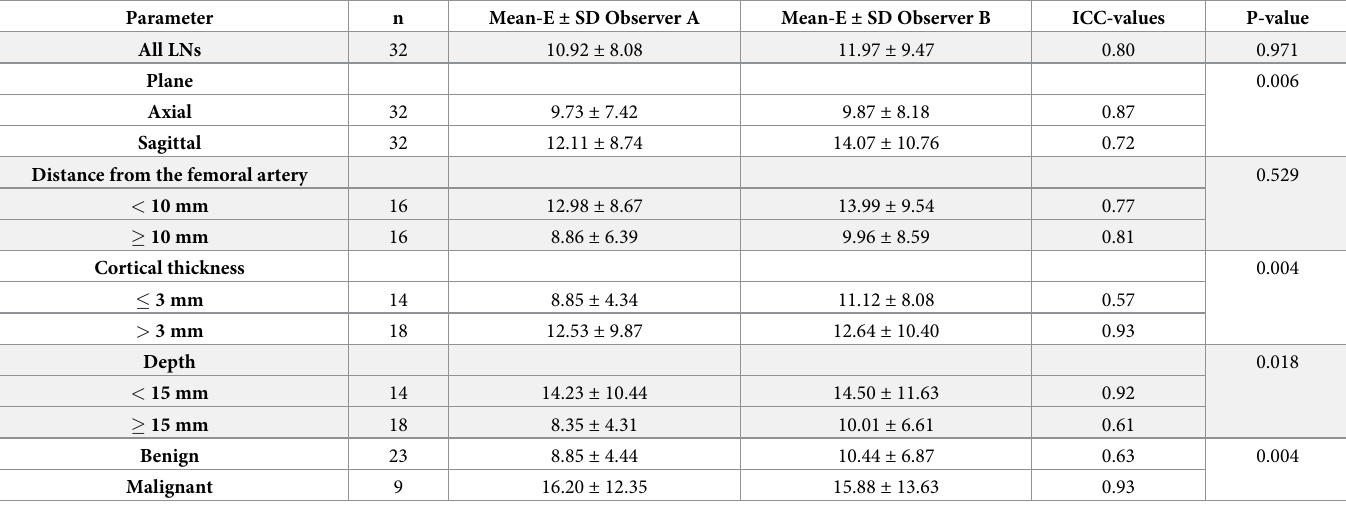
Table 4. Effect of different parameters on reproducibility of SWE elastography, assessed by intraclass correlation coefficient (ICC) values.